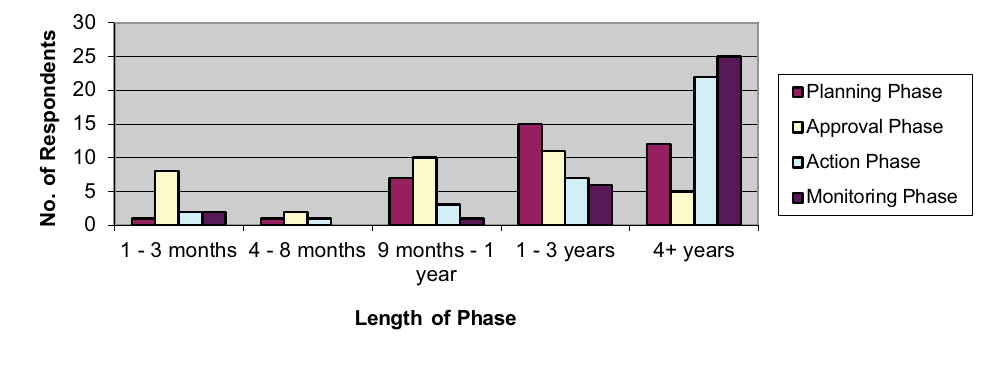
programs.Figure 3. Reported length of reintroduction program